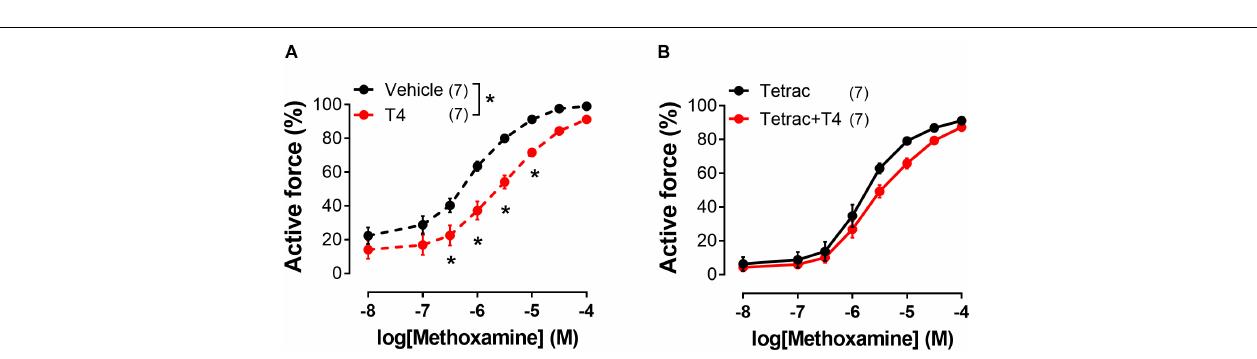
FIGURE 3 | T4-induced suppression of contractile responses of sural arteries to methoxamine persists in the presence of nitric oxide synthase inhibitor L-NNA. Concentration-response relationships to methoxamine obtained after preincubation with T4 or vehicle in the absence (A) or presence of L-NNA (B) (100 µ M). Number in parentheses represents the number of animals. * p < 0.05 compared to respective control group (Repeated Measures ANOVA with Tukey’s post hoc test).